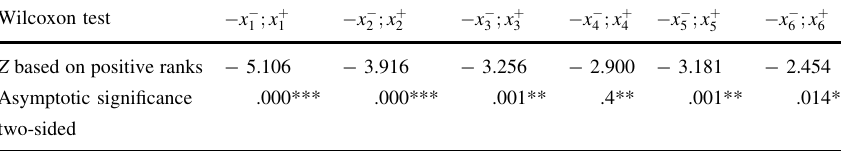
Table 4 Wilcoxon difference test between gains and losses for all elicited